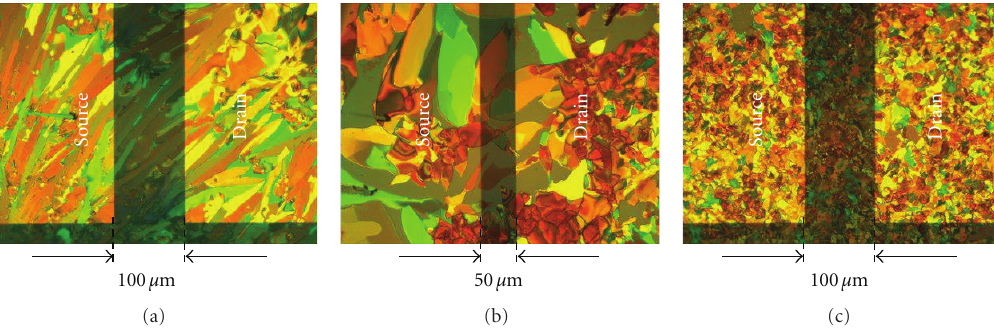
Figure 2: Optical micrograph of TFTs sprayed from a solution in chlorobenzene, under three argon pressures: (a) 5psi, (b) 10psi, and (c) 25psi. The source and drain gold contacts are indicated.